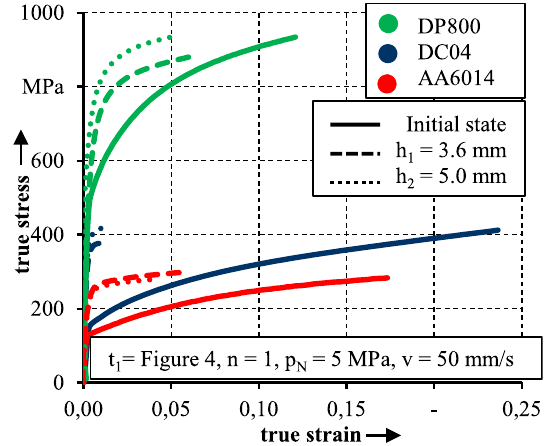
Fig. 5. True stress – true strain diagram of initial and preloaded specimens for all materials and drawbead heights h 1 and h 2 ( p N =5.0MPa, v